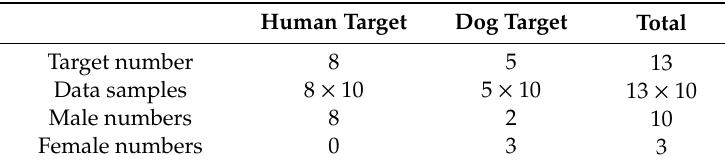
Table 2. Detailed information of experimental